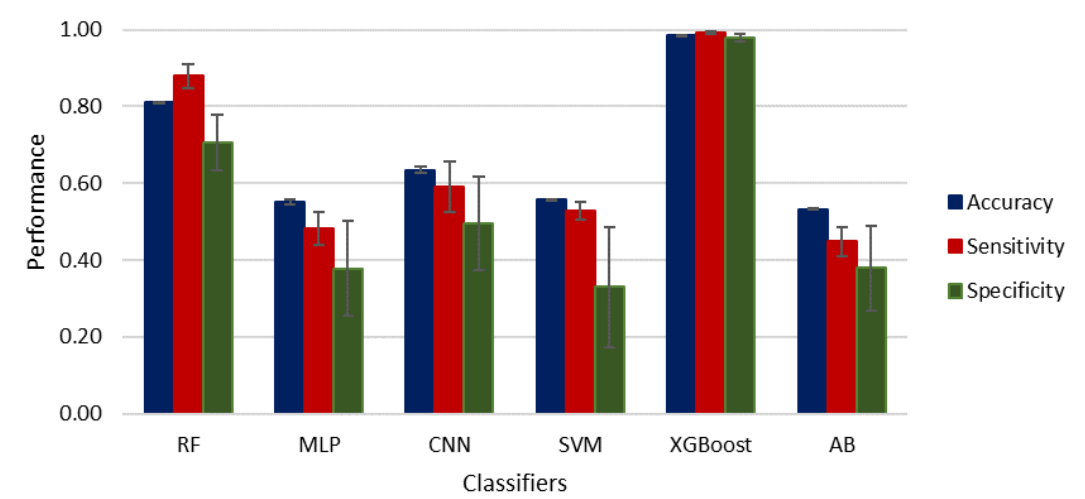
Figure 7. Classification performance, tubers differentiation phenological stage using four classes. Table 2. Comparison of classification performance of RF, MLP, and CNN alone and using MV for tubers differentiation phenological stage using two classes.